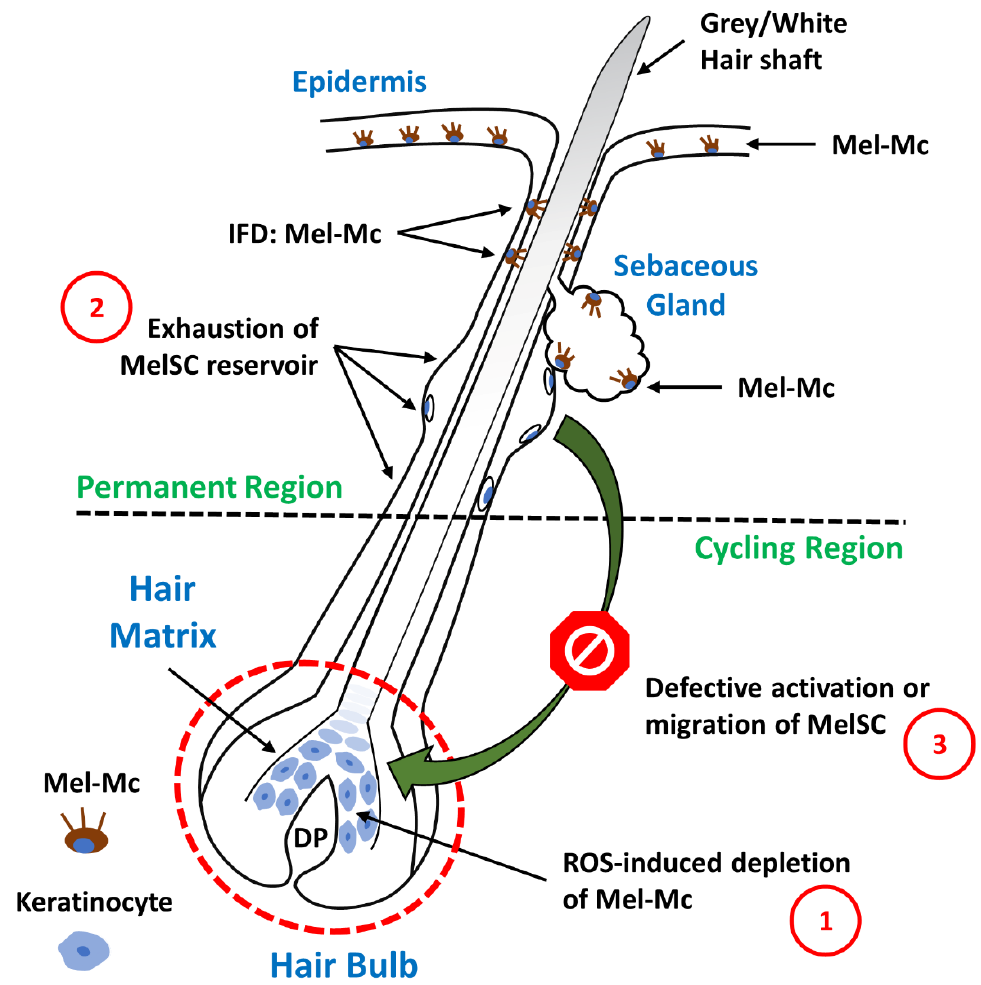
Figure 9. Proposed causes for hair greying during aging. The age-related pigment loss in hair fibres may be caused by the following: (1) depletion of melanotic melanocytes (Mel-Mc) in the hair matrix. Intrinsic (melanogenesis generates ROS) and extrinsic (inner root sheath and pre-cortical keratinocyte terminal differentiation involves ROS generation) sources of ROS may lead to oxidative damage of bulb melanocytes if antioxidant systems start to fail. (2) Exhaustion of the melanocyte stem cell (MelSC) reservoir, and (3) MelSC defective activation or migration during the onset of the anagen phase of the hair growth cycle. The inability to maintain MelSC quiescence due to ageing, oxidative stress, and stress-induced sympathetic nervous activity results in ectopic MelSC differentiation. Differentiated melanocytes are no longer able to replenish the pigmentary unit in the beginning of the hair cycle.